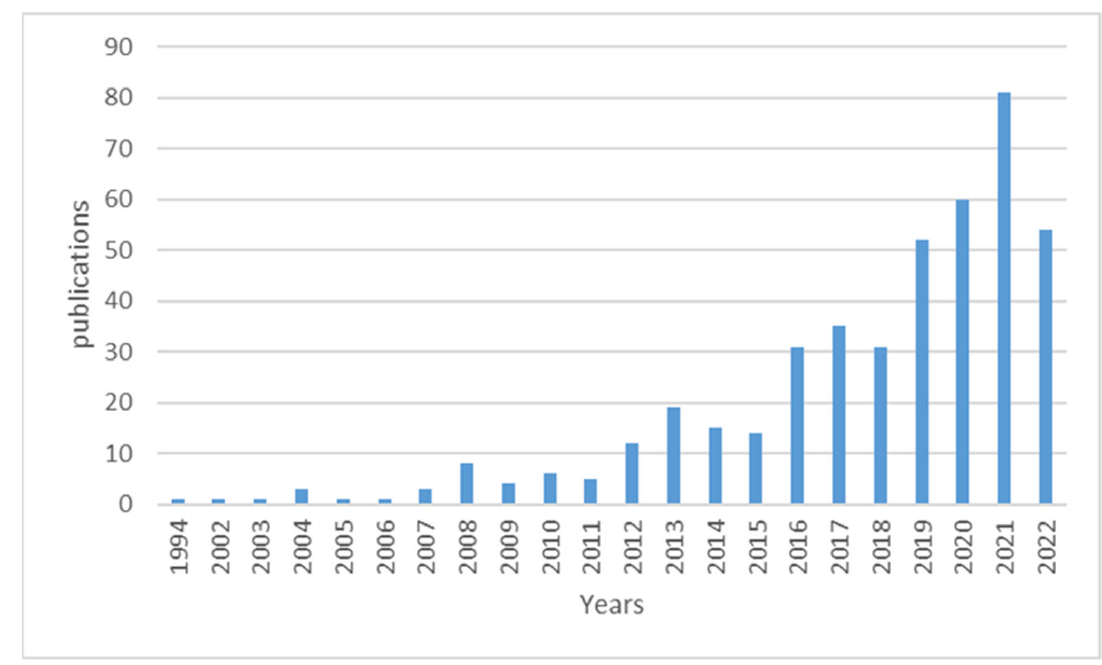
Figure 2. Annual distribution of publications on prenatal exposure to air pollution.